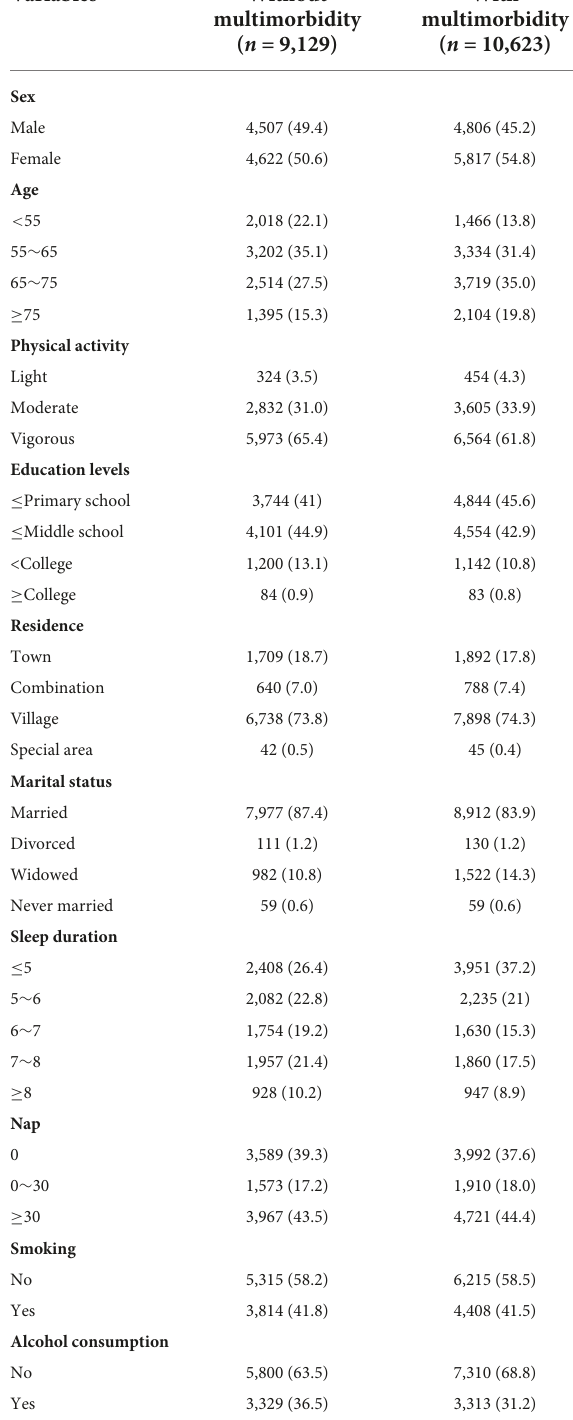
TABLE 1 Baseline characteristics of individuals with and without